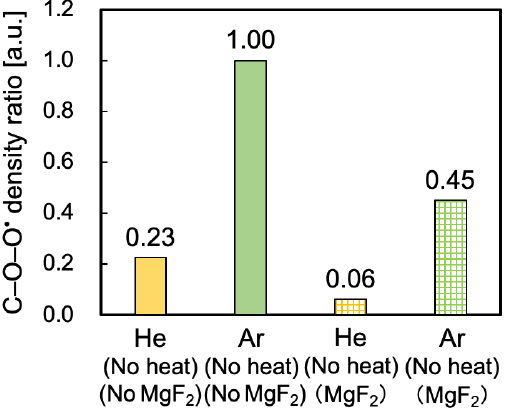
Figure 9. Peroxy radical density ratios calculated from the ESR spectra of the PTFE samples plasma-treated using He or Ar gas without or with an MgF 2 substrate and without using a heater. Each radical density ratio was normalized based on the ESR spectrum of the PTFE samples plasma-treated using Ar gas without an MgF 2 substrate.